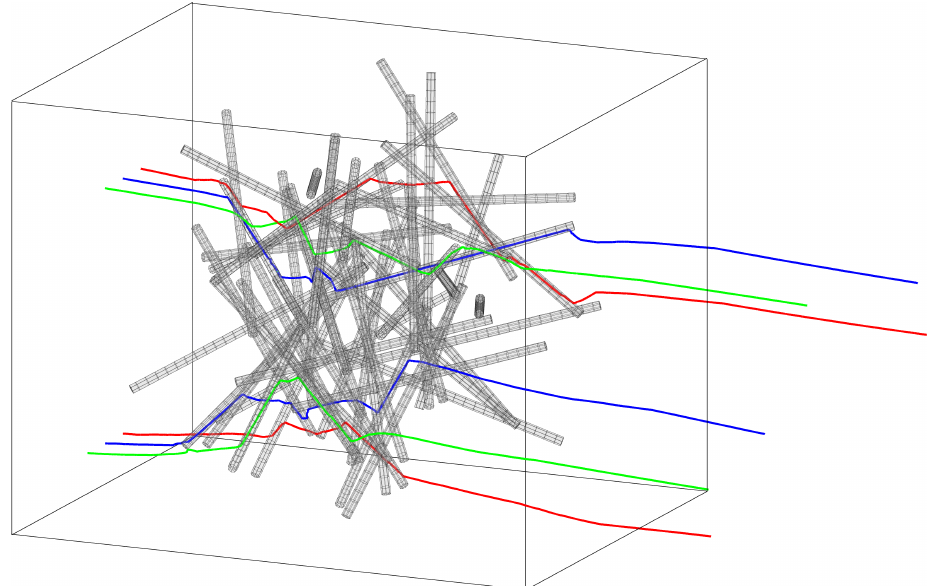
Figure 6. Flow through a cluster of conductive fibers embedded within a lowly conductive matrix. The fiber aspect ratio l f / d f =